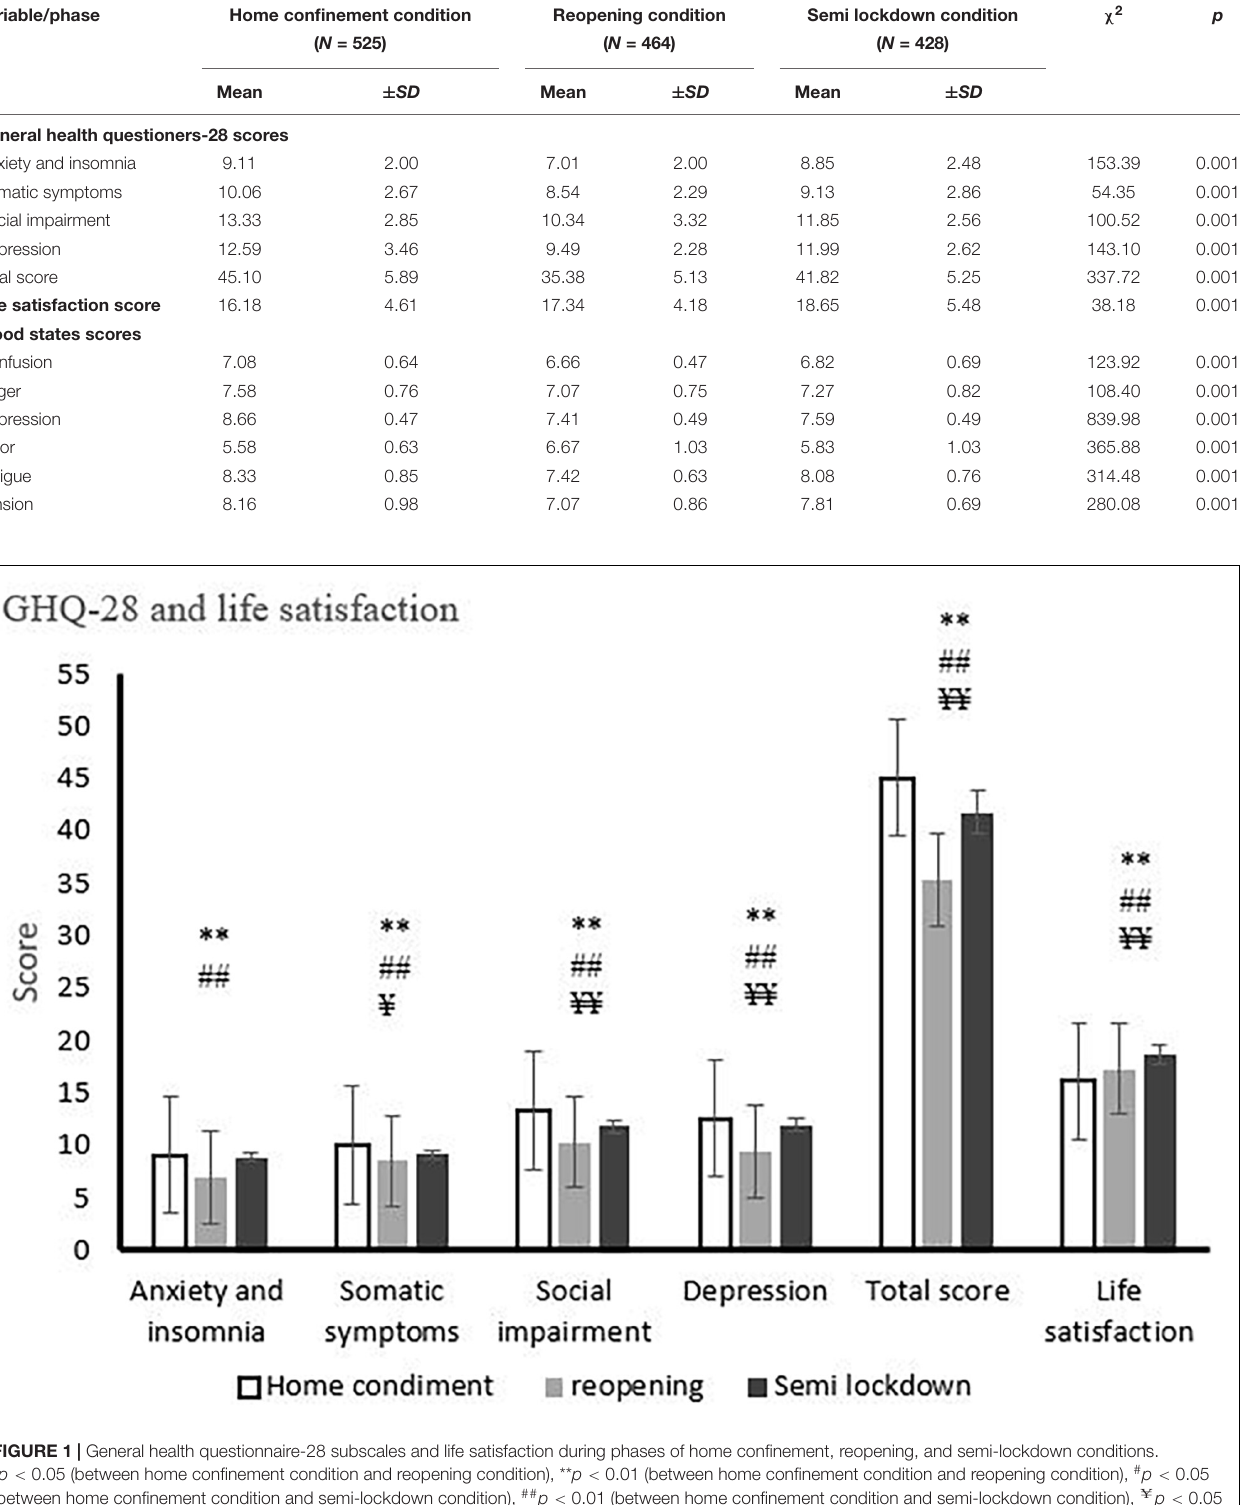
TABLE 3 | Changes in factors of General health questionnaire-28, Life satisfaction and Mood states for the three phases of study and results from Friedman test.